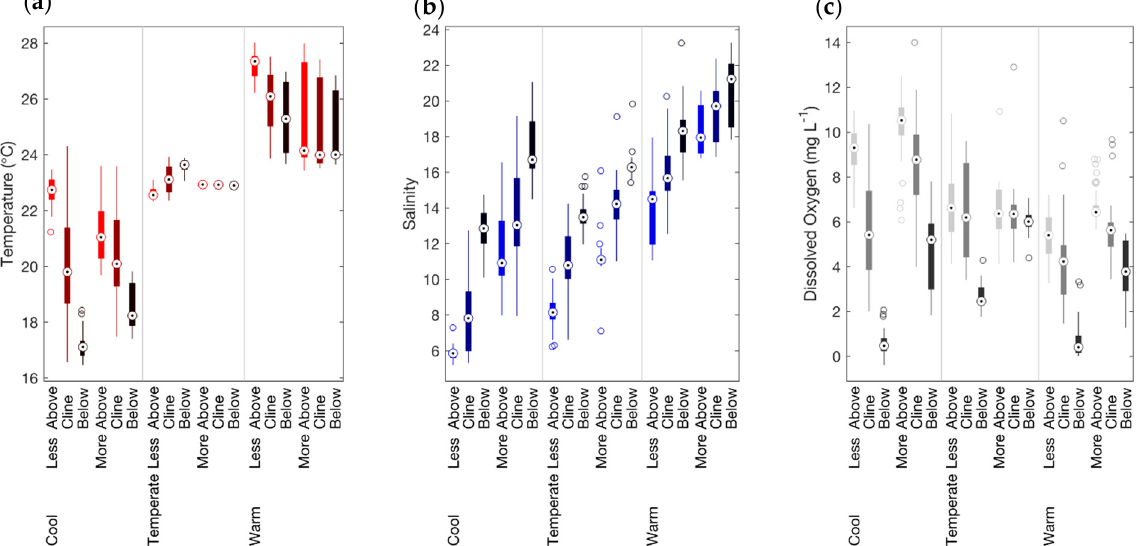
Figure 8. Temperature ( a ), salinity ( b ), and dissolved oxygen ( c ) from above, at, and below the pycnocline in the Cool, Temperate, and Warm groups. Circles with dots indicate medians, bars indicate 25 to 75 percentiles, lines indicate 5 to 95 percentile, and open circles indicate outliners. Table 4. The Kruskal-Wallis test on di ff erences in concentrations of zooplankton and fish between the more-oxygenated (MO) and less-oxygenated (LO) subgroups within the cool (C), temp (T), and warm (W)